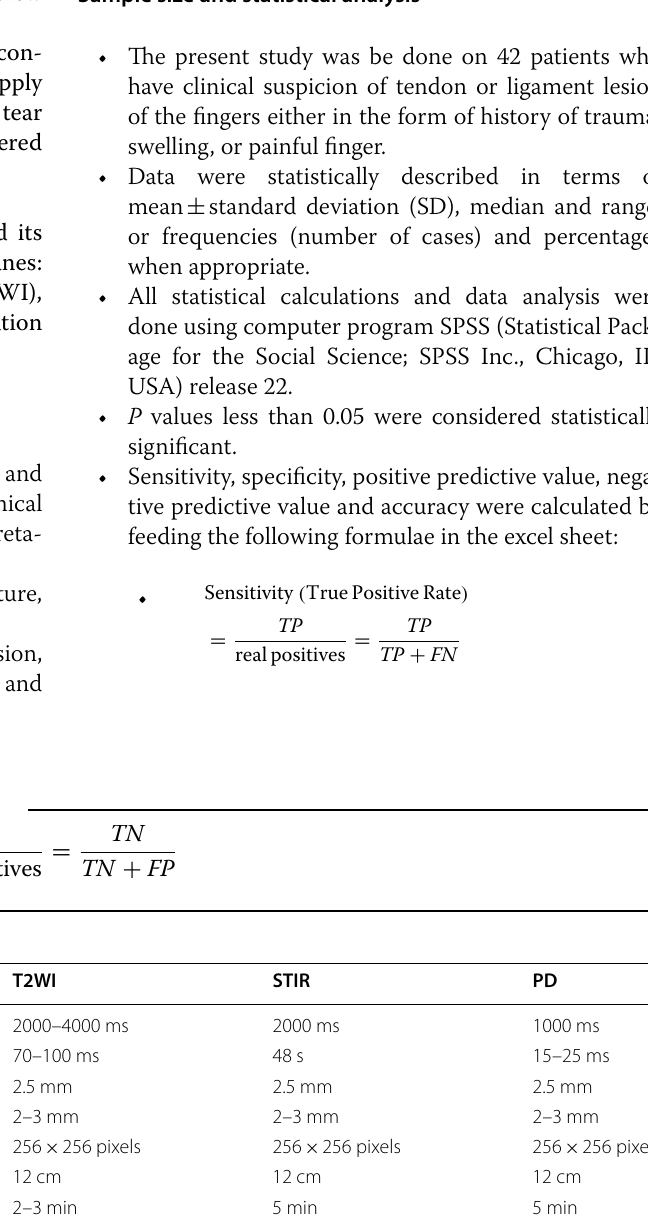
TR; Repetition time, TE; echo time, FOV; field-of-view, STIR; short tau inversion recovery, PD; proton density, msec; millisecond, sec; second, mm; millimeter, cm; centimeter